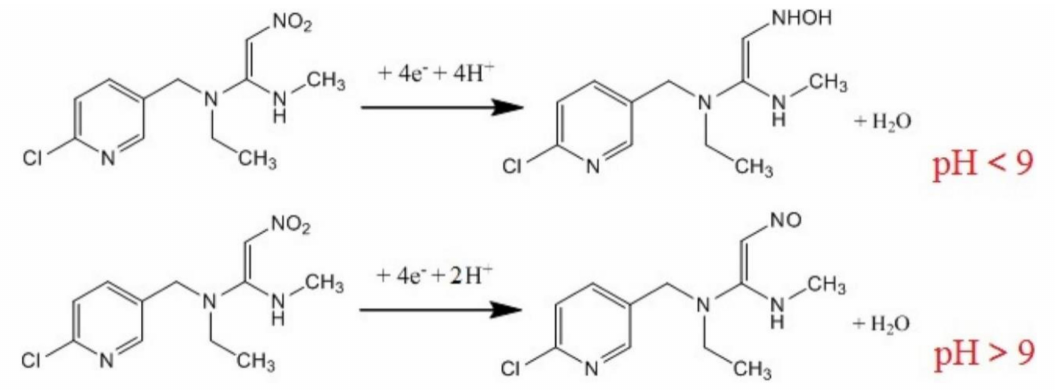
Figure 7. The scheme of the electrochemical reduction of nitenpyram. Reprinted from [156] with permission of